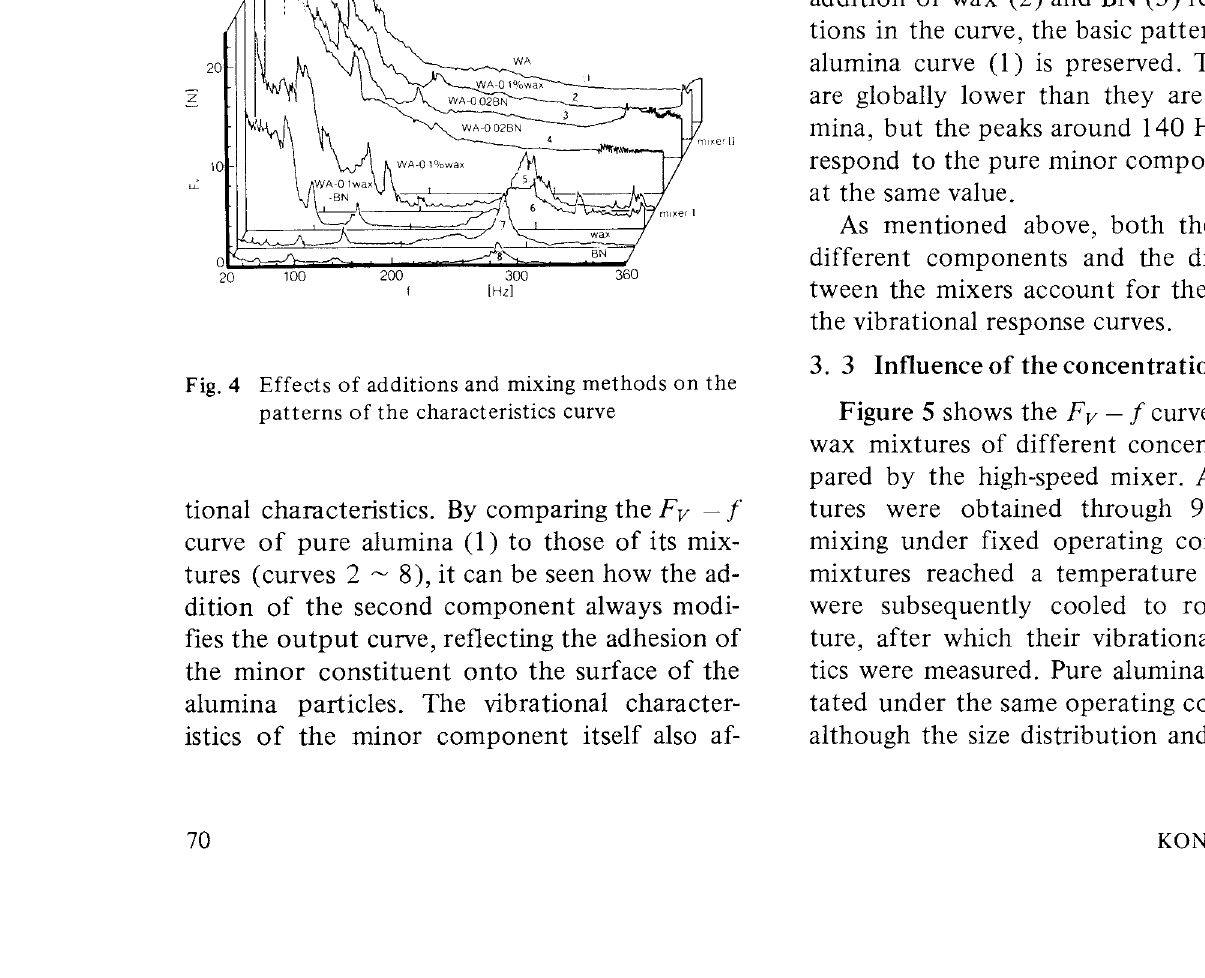
Fig. 4 Effects of additions and mixing methods on the patterns of the characteristics